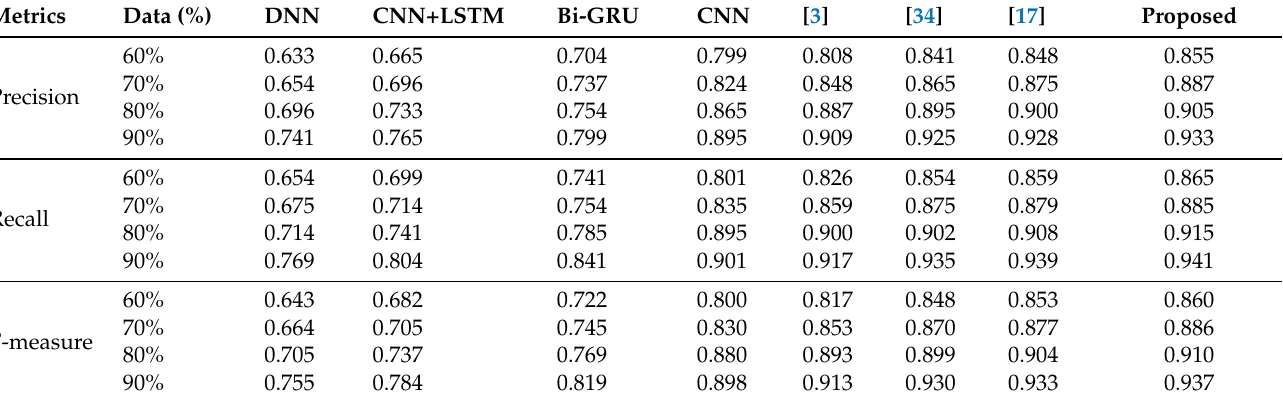
Table 6. Comparative analysis of Review Rating Prediction for Yelp 2013 dataset in terms of precision, recall and